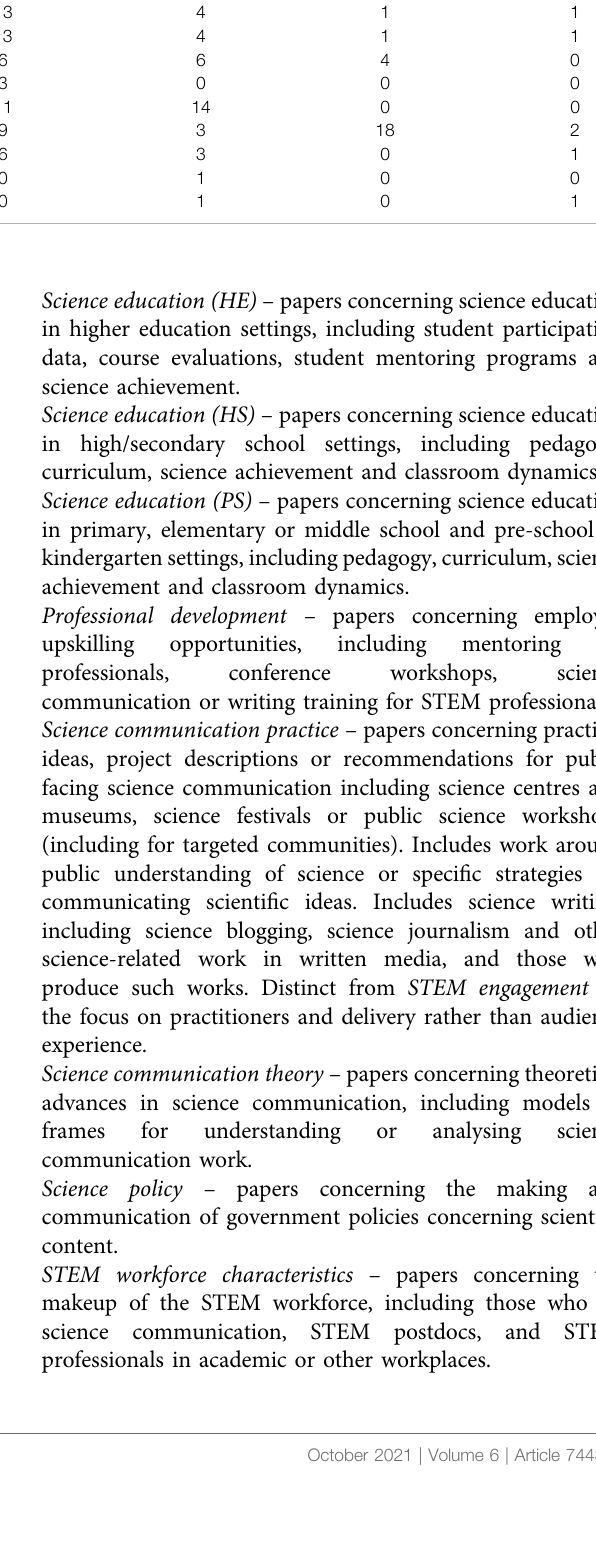
Table 2 outlines how the different paper goals aligned with different audiences. Across all audiences, papers which focused on audience experience and evaluation were most common.